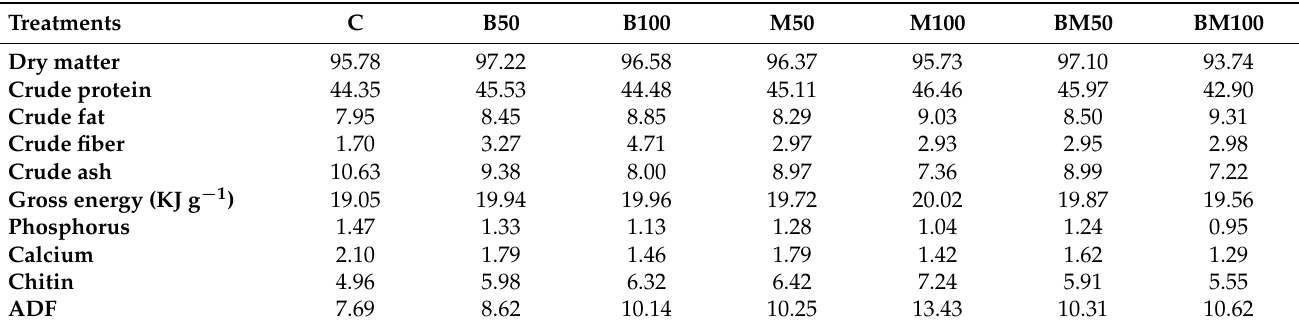
Table 2. Proximate composition (% wet weight basis) of the diets with different inclusion level of insect meal